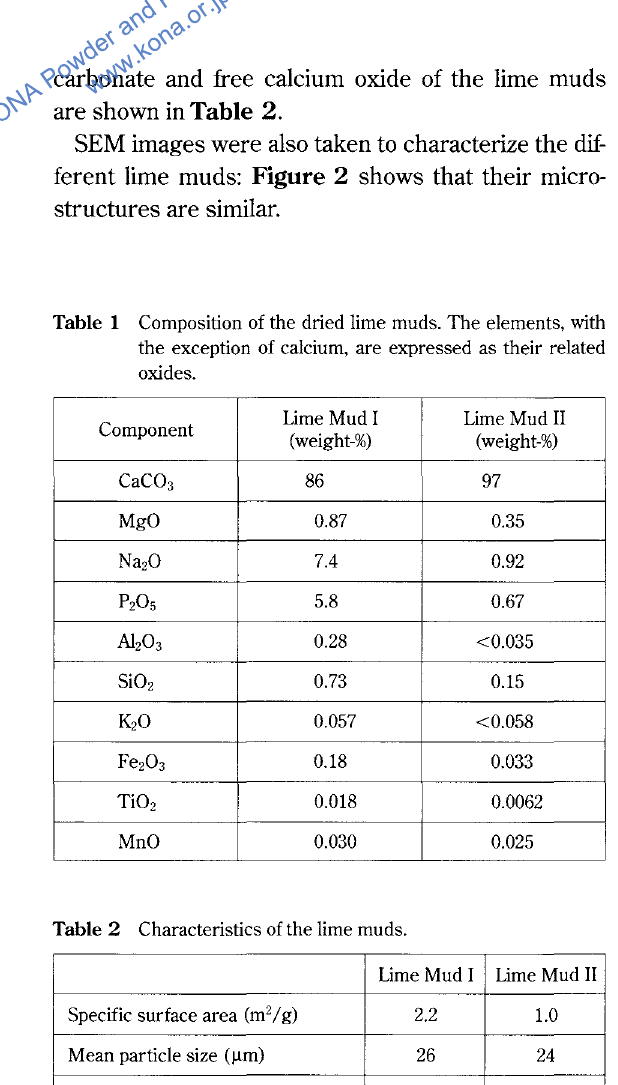
Table 2 Characteristics of the lime